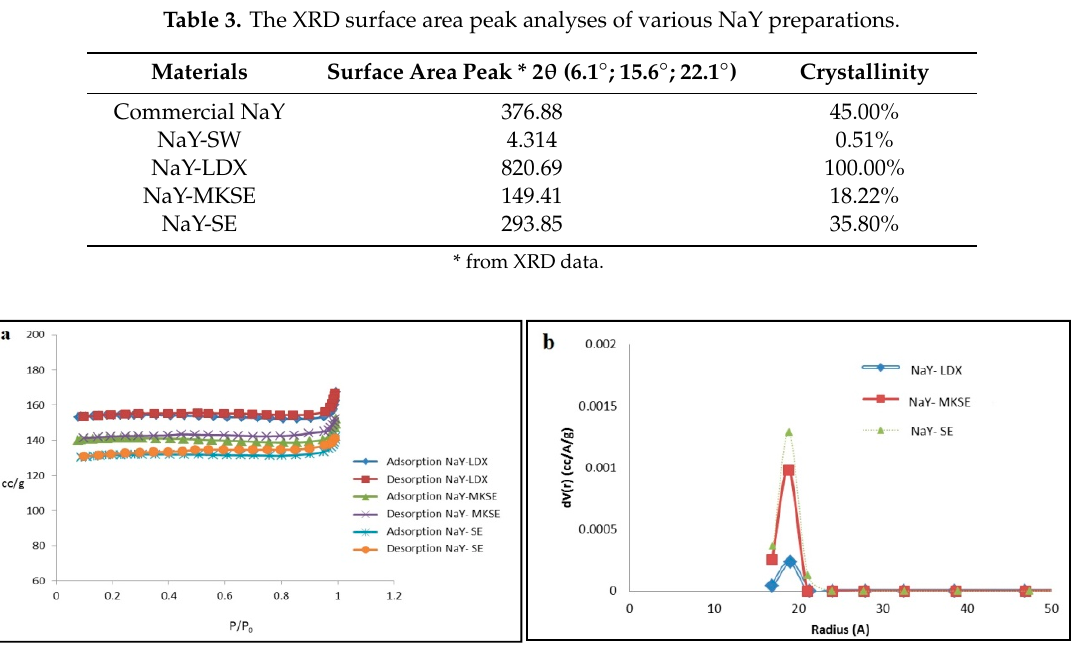
Figure 11. The ( a ) adsorption and desorption data and ( b ) pore distribution data of NaY. Table 4. The surface area analysis results of the as-synthesized NaY